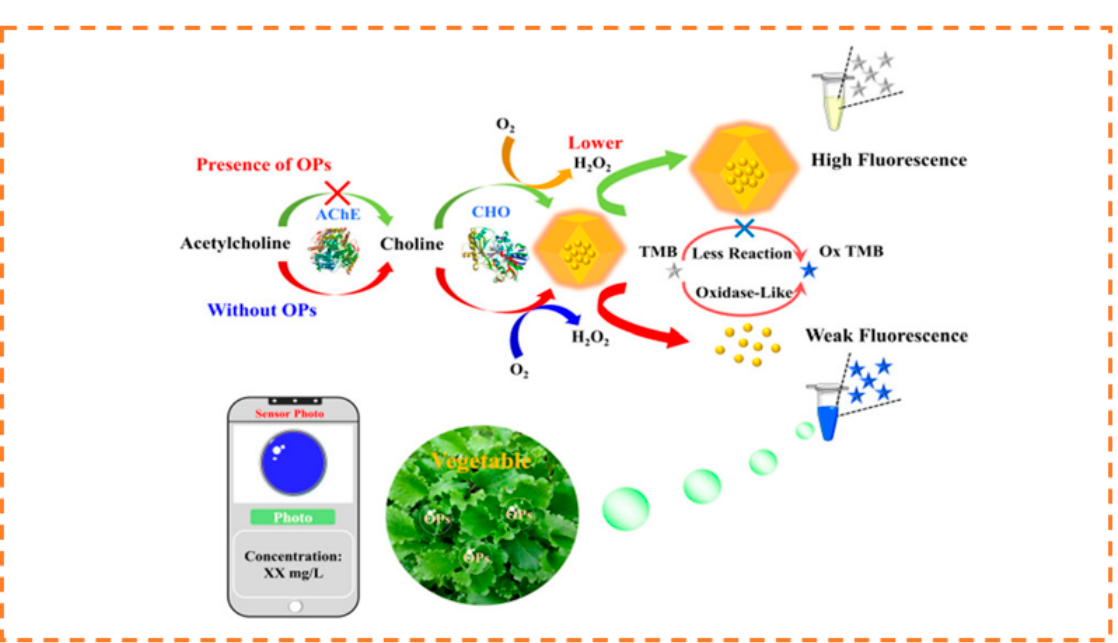
Figure 10. Schematic illustration of the mechanism for the detection of OPs. Reproduced with per- mission from [158]. Copyright 2021, American Chemical Society.